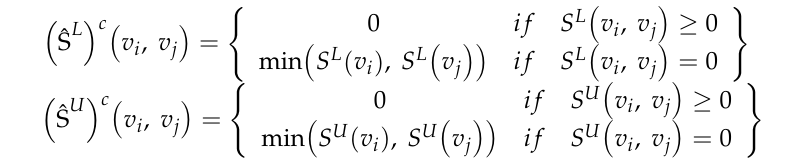
Figure 9. Complement of graph depicted in Figure 8 based on Definition 8, giving us undefined intervals.